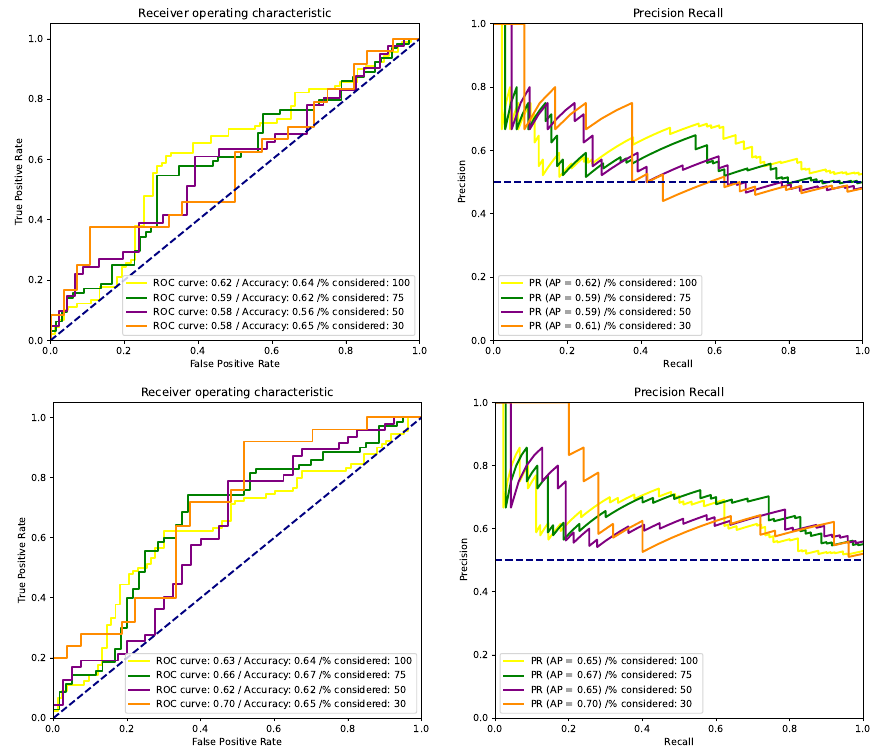
Figure 1. ROC and PR curves with FLAIR-T1wCE inputs for ( top ) baseline [20] and confidence branch [23] ( bottom ). Table 2. Results of confidence metrics on the validation set. FLAIR-T1wCE, early fusion. A value set